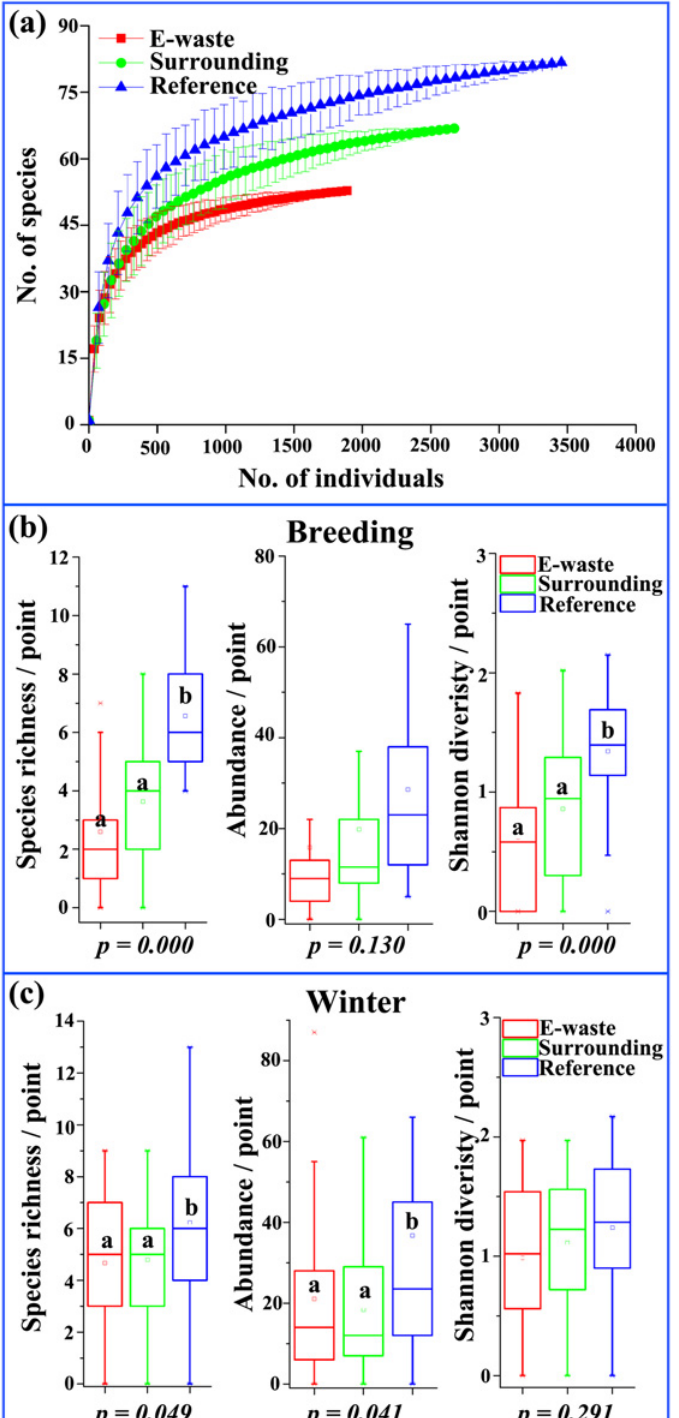
Fig 2. Sampled-based rarefaction curves (a); box and whisker plots comparing mean point species richness, abundance, and diversity among sites from e-waste exposed ( n = 30 ), surrounding ( n = 30 ) and reference sites ( n = 30 ), occurring in breeding (b) and winter (c) season. Curves were generated by Monte-Carlo simulations with 95% confidence intervals (on the total number of species vs. individuals observed). Site estimates are based on standardized point counts where bird numbers were counted for